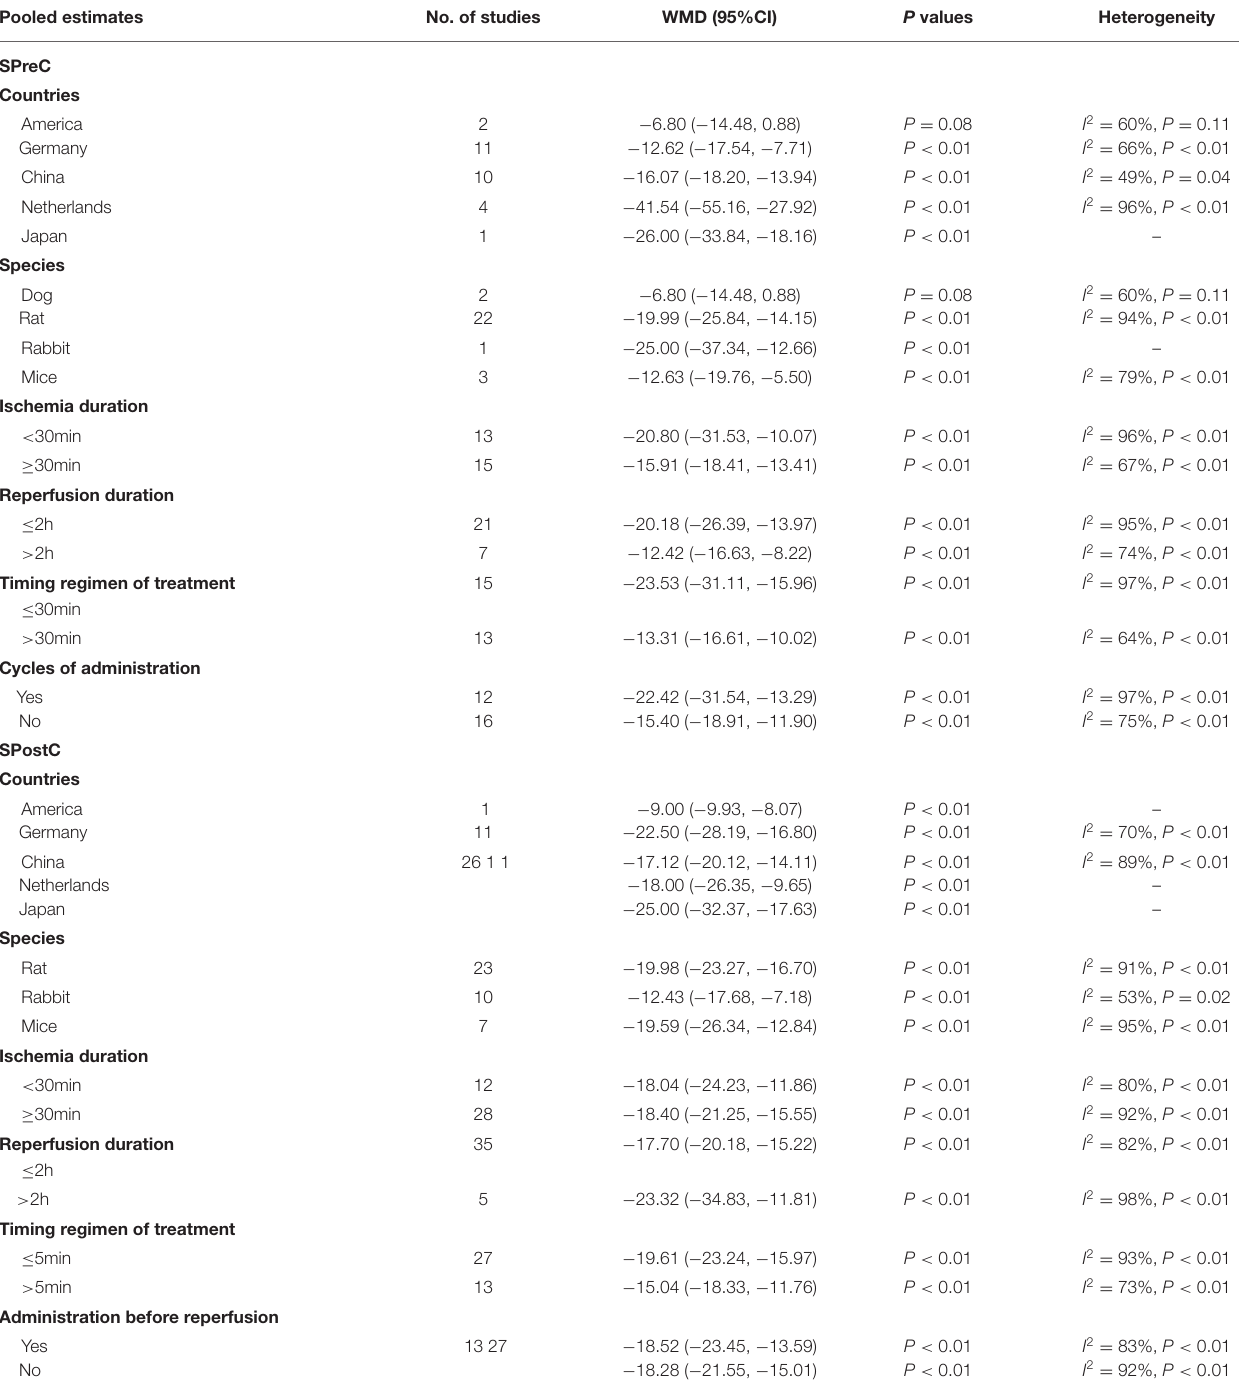
TABLE 3 | Stratified analysis of pooled estimates for infarct size sparing in the included studies of SPreC and SPostC. Pooled